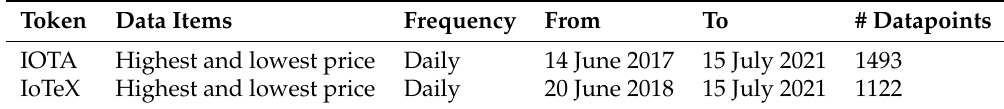
Table 6. Data points analysed in this